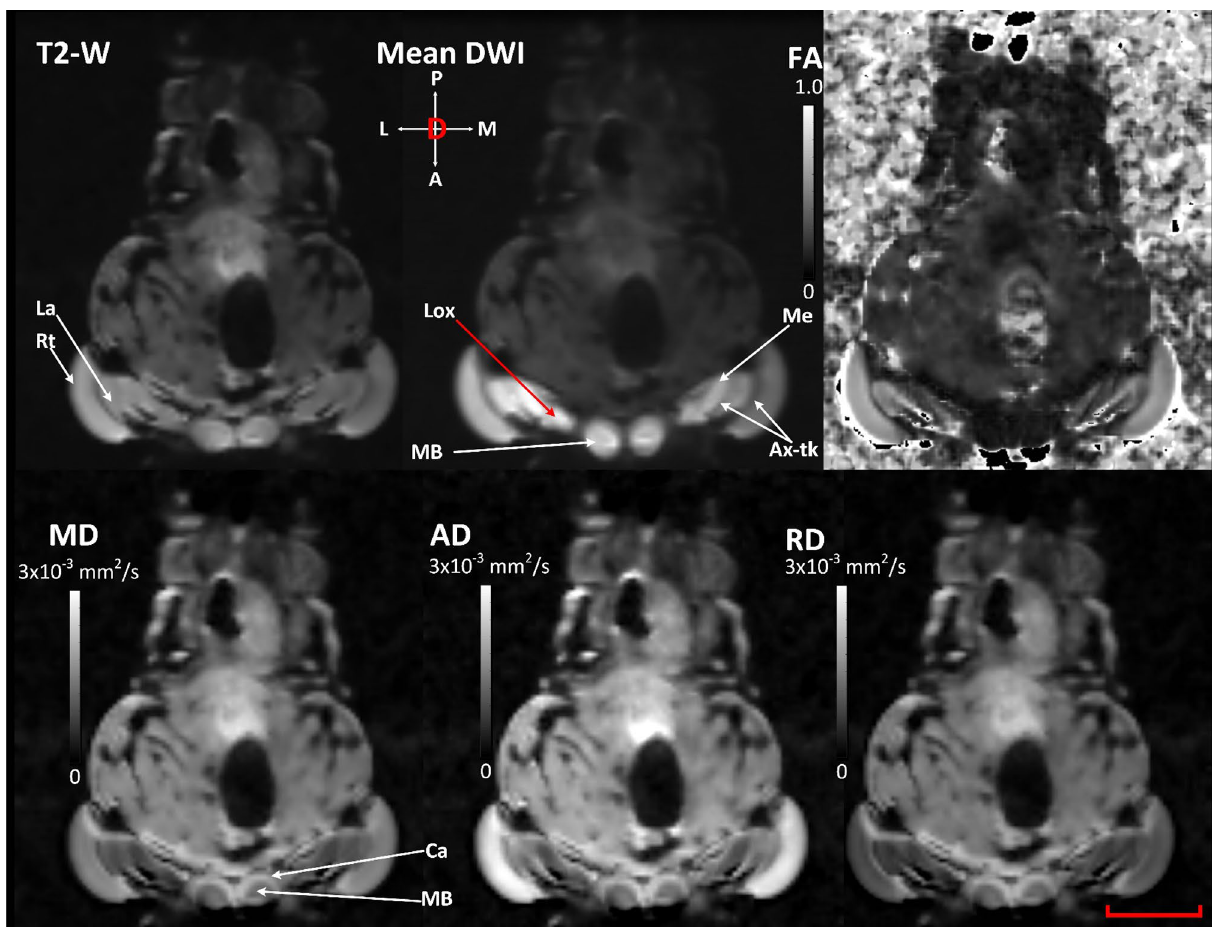
Figure 2. Axial slice, dorsal view from live sample illustrating various anatomical structures and their diffusivity profile using qualitative and quantitative scalar maps. T2-W and mean DWI based contrasts are qualitative in nature and their pixel/voxel intensity scales are arbitrary. FA, MD, AD and RD are quantitative scalar maps, in this study they were derived from DKI model. In T2-W map, regions exhibiting longer transverse relaxation (T2-relaxation) are hyperintense and regions exhibiting shorter transverse relaxation are hypointense. In averaged DWI based map, regions of low diffusivity are hyperintense and regions of high diffusivity are hyperintense. FA measures the degree of directional (diffusivity) anisotropy and has a range between 0 and 1. High FA values suggest higher directionality of diffusion. MD represents the mean diffusion rate within a voxel, with higher values representing increased diffusivity or isotropy. AD represents the rate of diffusion along the principal diffusion direction. RD represents the rate of diffusion transverse to the principal diffusion direction. The range of MD, AD and RD is from 0 to 3 × 10 –3 mm 2 /s. Ax-tk axonal tracts, Ca Calyx, La lamina, Lox lobula complex, MB mushroom body, Me medulla, P peduncles, Rt retina. Scale bar 500 similarly, fibres between medulla and Lox, which are known to form chiasms are identifiable (highlighted as Ax-tk in figures). This is possible as fibre tracts have been directionally encoded in the figures with the colour of the fibre representing its orientation. From Fig. 1b, the chiasms are identifiable in the tone of blue/purple. Therefore a perfectly vertical fibre would be displayed in pure blue colour (as marked by the crosshair). Similarly, perfectly horizontal fibres would be displayed in pure red. Any change in the orientation of the fibre from three orthogonal directions are represented by the mixture of multiple colours. From Figs. 1e,f, 2, 3 and 4c,d, the regions of darker shades between adjacent lamina and medulla and between Lox and medulla clearly highlight those chiasms (Ax-tk). The chiasms can also be identified in the ex-vivo locust in the fractional anisotropy (FA) modulated directionally encoded colour (DEC) map (supplementary Fig. S1b, Ax-tx, highlighted by yellow arrows). Using the color encoded projections of inferred axonal tracts from synaptic neuropils, it is possible to estimate the micro-diffusion environment (Figs. 1 and 4). The bundles of axonal fibres connecting the synaptic centers of the optic lobes towards the brain can be seen from Figs. 1b,d,g and 4b,f,h. Regions that show high contrast in Fig. 4c (insets 1–7) are Rt, MB, Lox, Me, La, CC, AL and Tritocerebral lobe. Similarly, Fig. 4d (insets 8–11) show good classification of midbrain neuropil (MN), MB, AL, La, Me and Lox. The central complex (CC), which has high synaptic density appears hypointense in the averaged DWI map, whereas, T2-W contrast shows clear delineation of CC and hypo-intense peduncles (P) (Figs. 1 and 4). The insets in Fig. 4b show the 3-dimensional representation of tracts in MB and CC using manually delineated region-specific (ROI-based) fibre tractography.